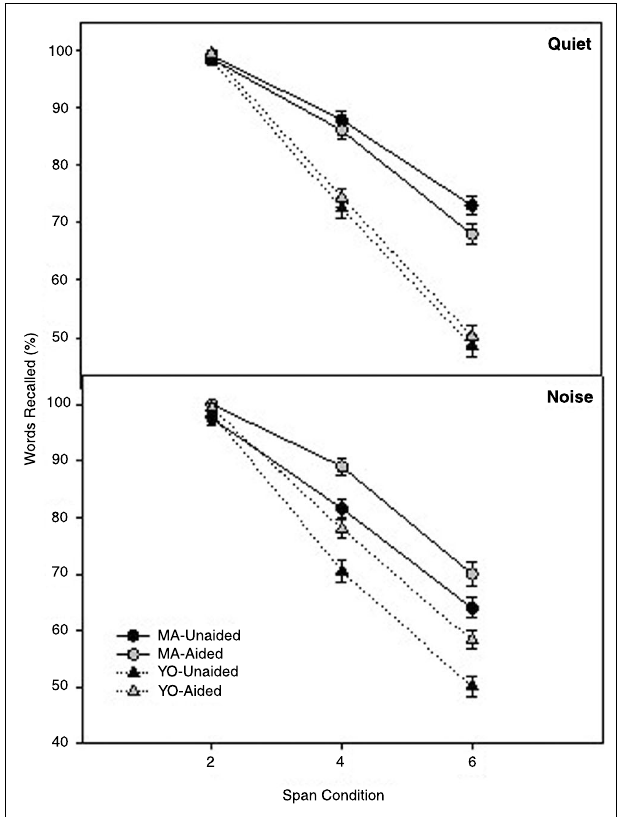
FIGURE 2 | Mean unaided and aided Listening Span test scores for the MA (circles) and YO (triangles) participants in quiet (top) and noise (bottom). Error bars represent (cid:6) 1 SE.